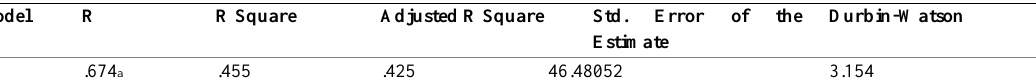
Table 2: The Autocorrelation Test Results